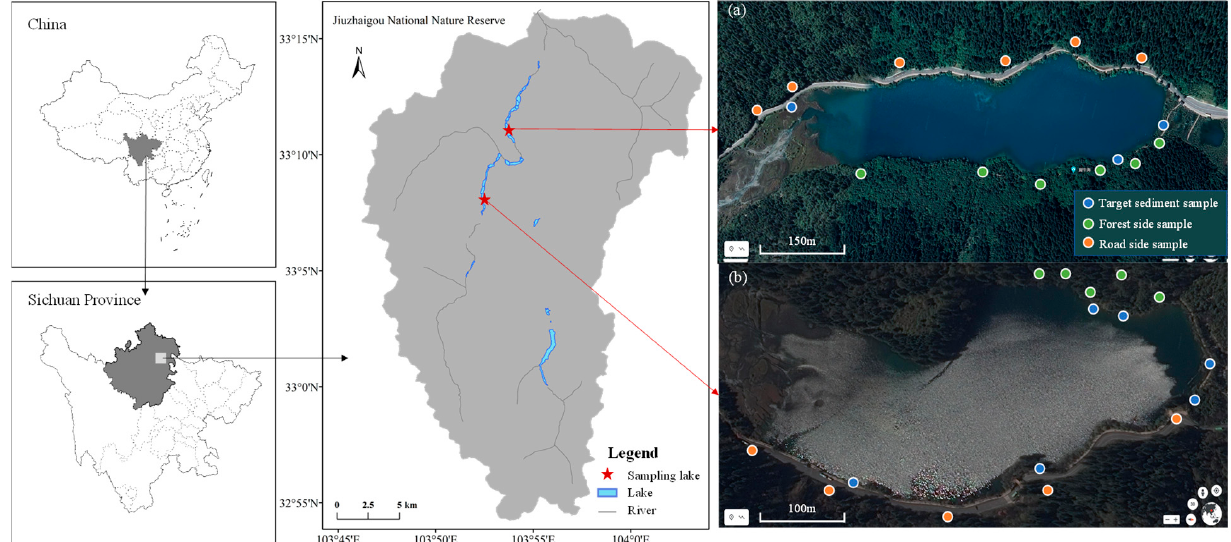
Figure 1. Study area (left and middle) and sampling sites (right). ( a ) Sampling sites at Rhino Lake; ( b ) Sampling sites at Arrow Bamboo Lake. The blue points in ( a ) and ( b ) are the target sediment samples, the green points are the forest side samples, and yellow points are the roadside samples.